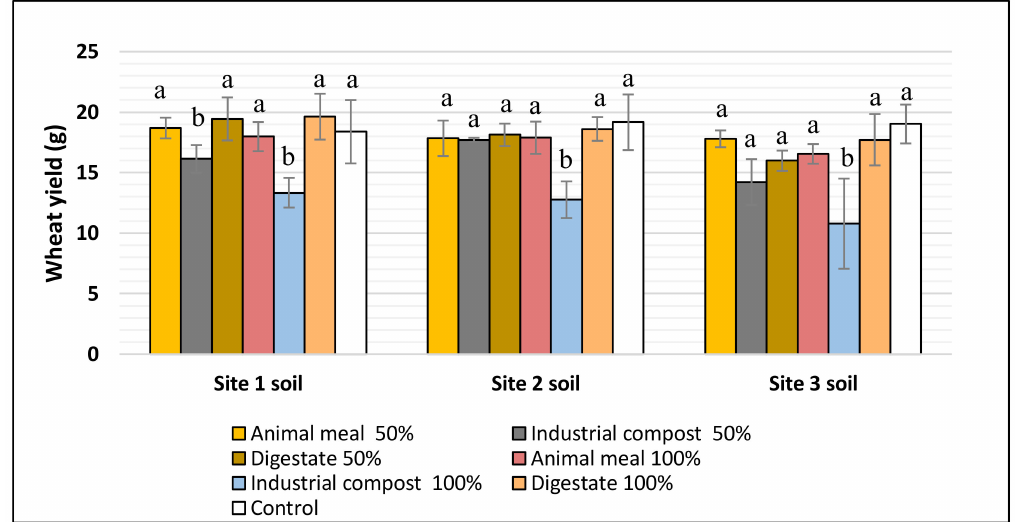
Figure 4. Impact of EOM addition on the total wheat biomass yield (dry matter of the plant). Lowercase letters indicate significant di ff erences between the treatments, calculated separately for individual sites based on Tukey’s test. Means marked with the same letter did not di ff er significantly ( p < 0.05). The obtained total yields of wheat grain largely reflected the total biomass results (r = 0.92, p < 0.05). The thousand grain weight (TGW) is the basic parameter characterizing the quality of grain